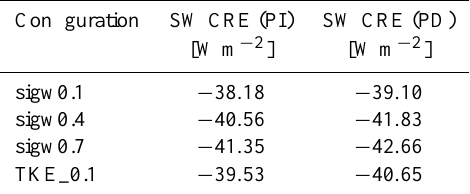
Table 5. Global mean RFPs due to total anthropogenic aerosol ef- fects for each of the vertical velocity configurations in HadGEM- UKCA.